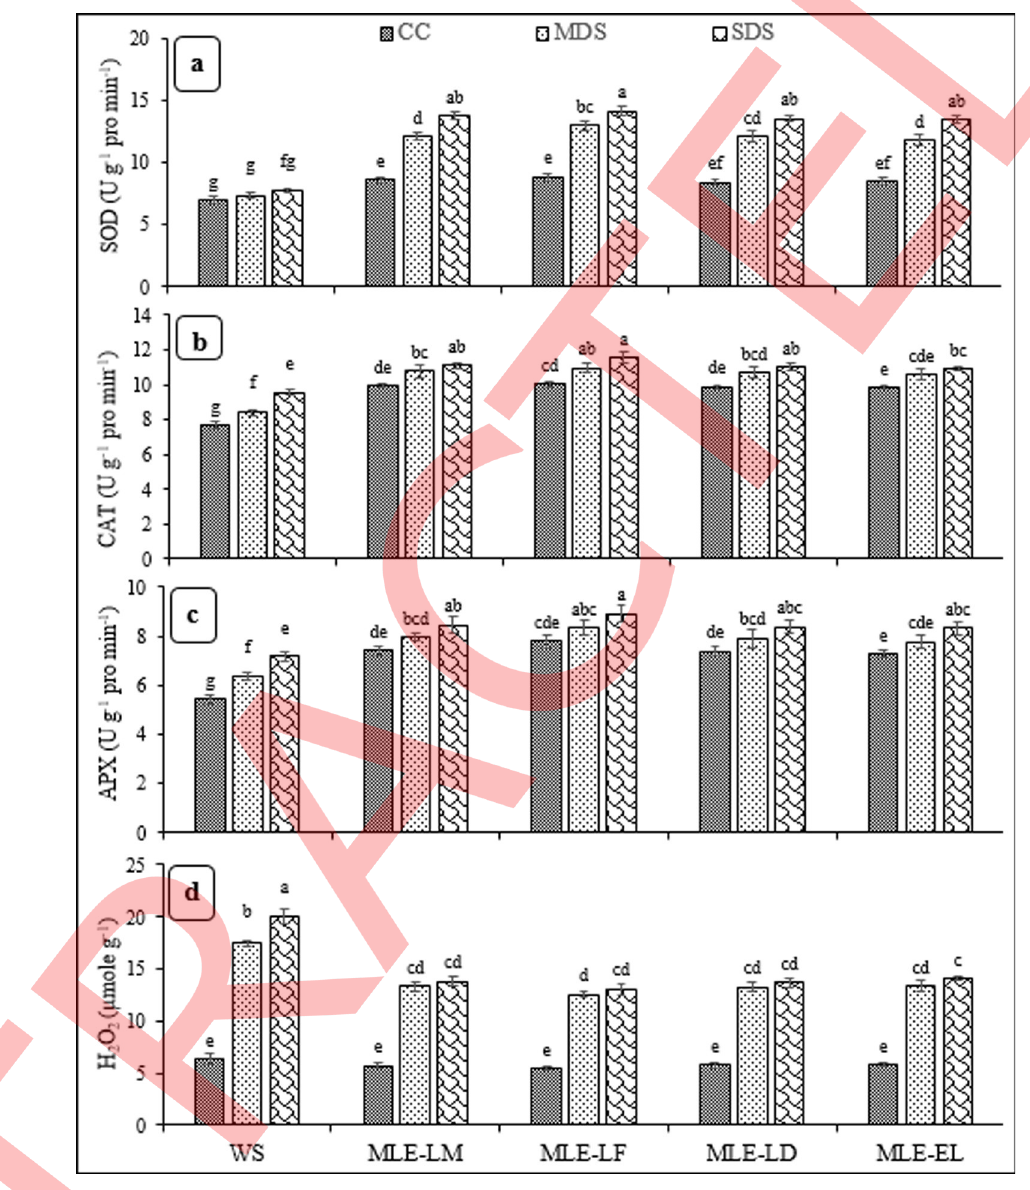
Fig 3. Impact of leaf extracts from local and exotic moringa landraces on superoxide dismutase (SOD) (a), catalase (CAT) (b), ascorbate peroxidase (APX) (c) and hydrogen peroxide (H 2 O 2 ) (d) of rice leaf cultivated under normal and drought-stressed environments (n =